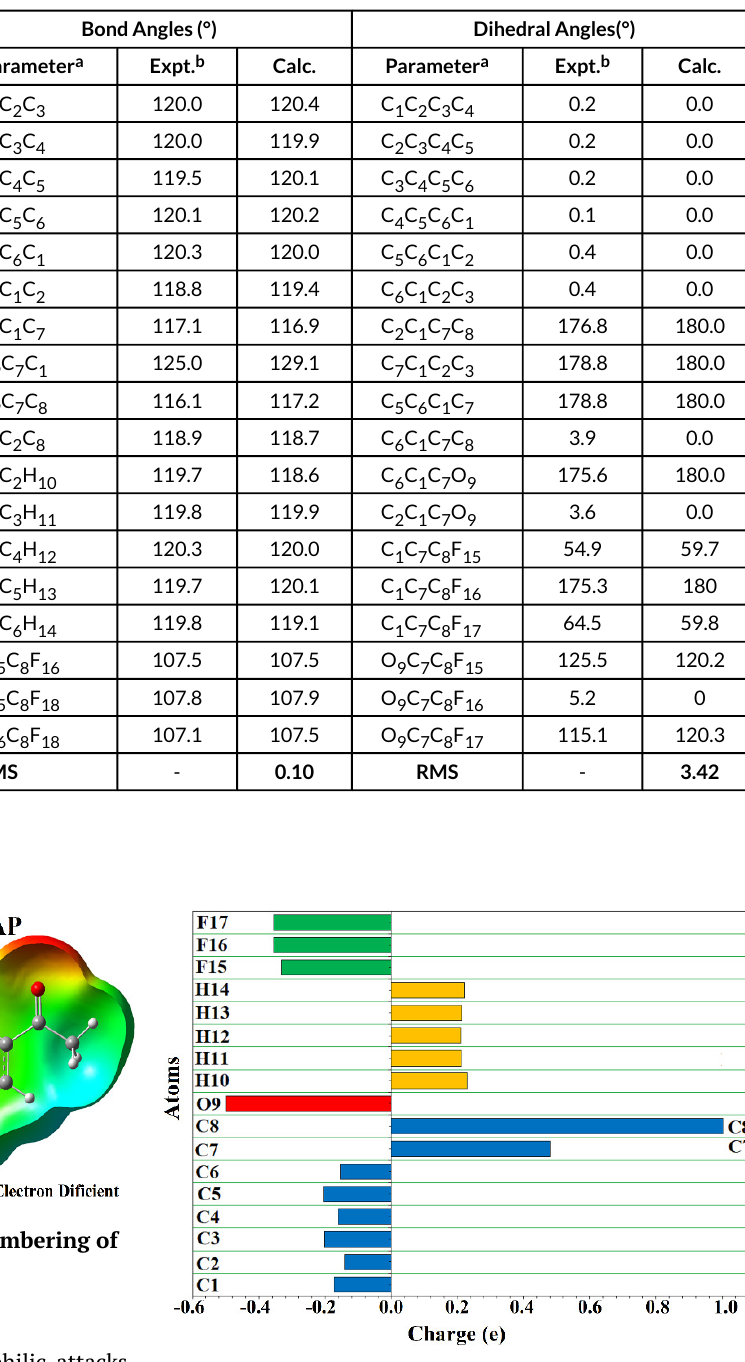
both molecules, the positive electron potentials are around the hydrogen atoms of the molecules. In addition, the phenyl rings of both molecules have an electrostatic poten- tial (green region) that corresponds to midway between red and blue, a potential site for intermolecular interactions. The MEP surface of TFAP is in agreement with the calcu- lated atomic charges of the optimized structure of TFAP (Figure